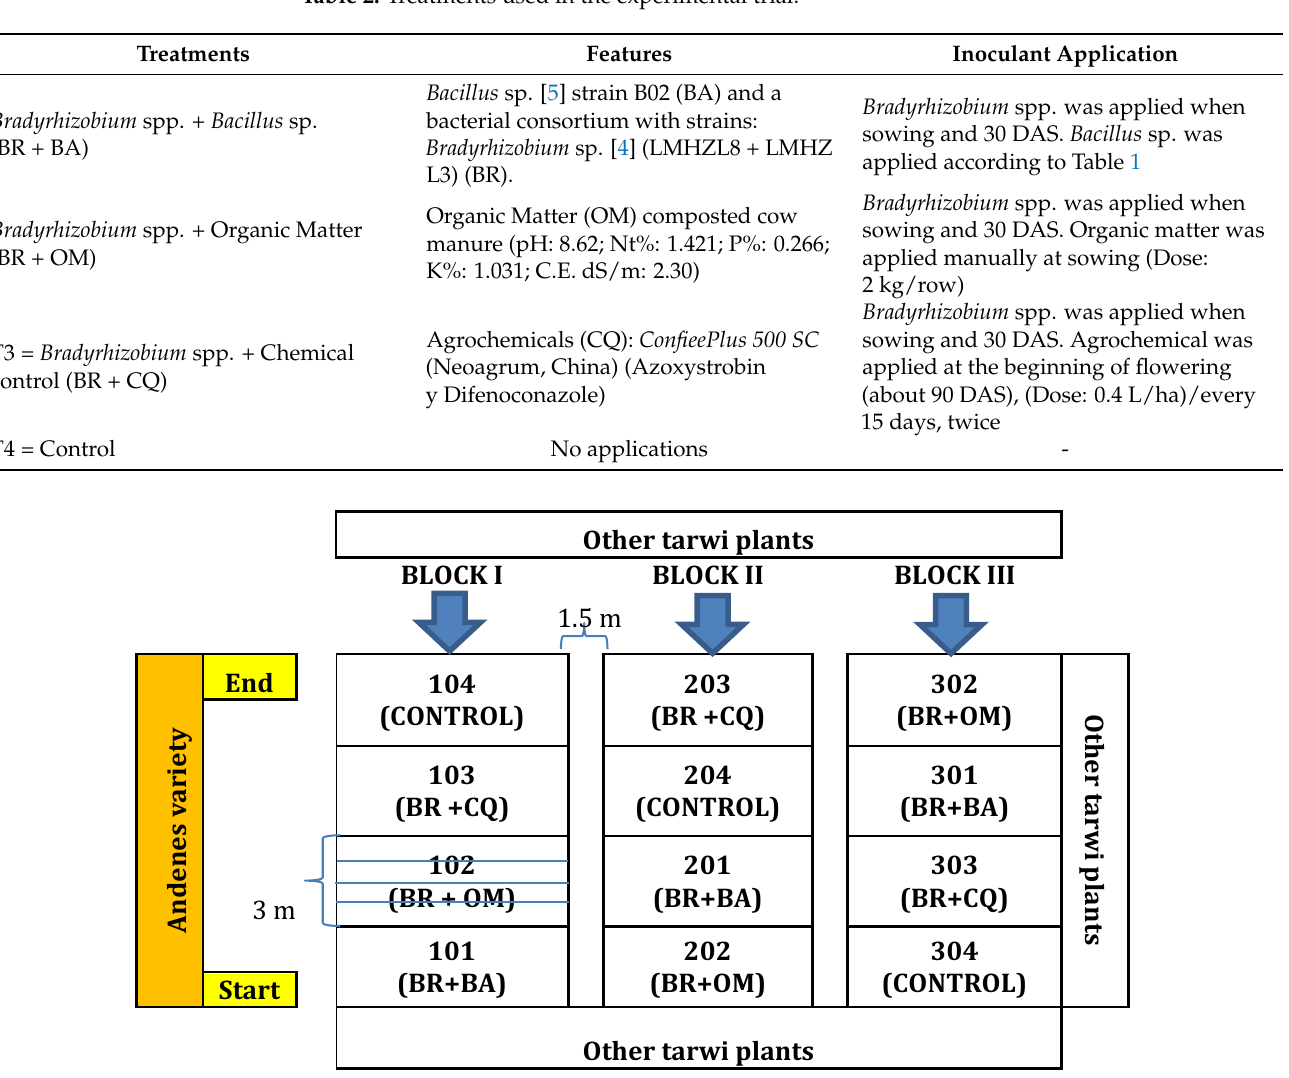
Table 2. Treatments used in the experimental trial. Treatments